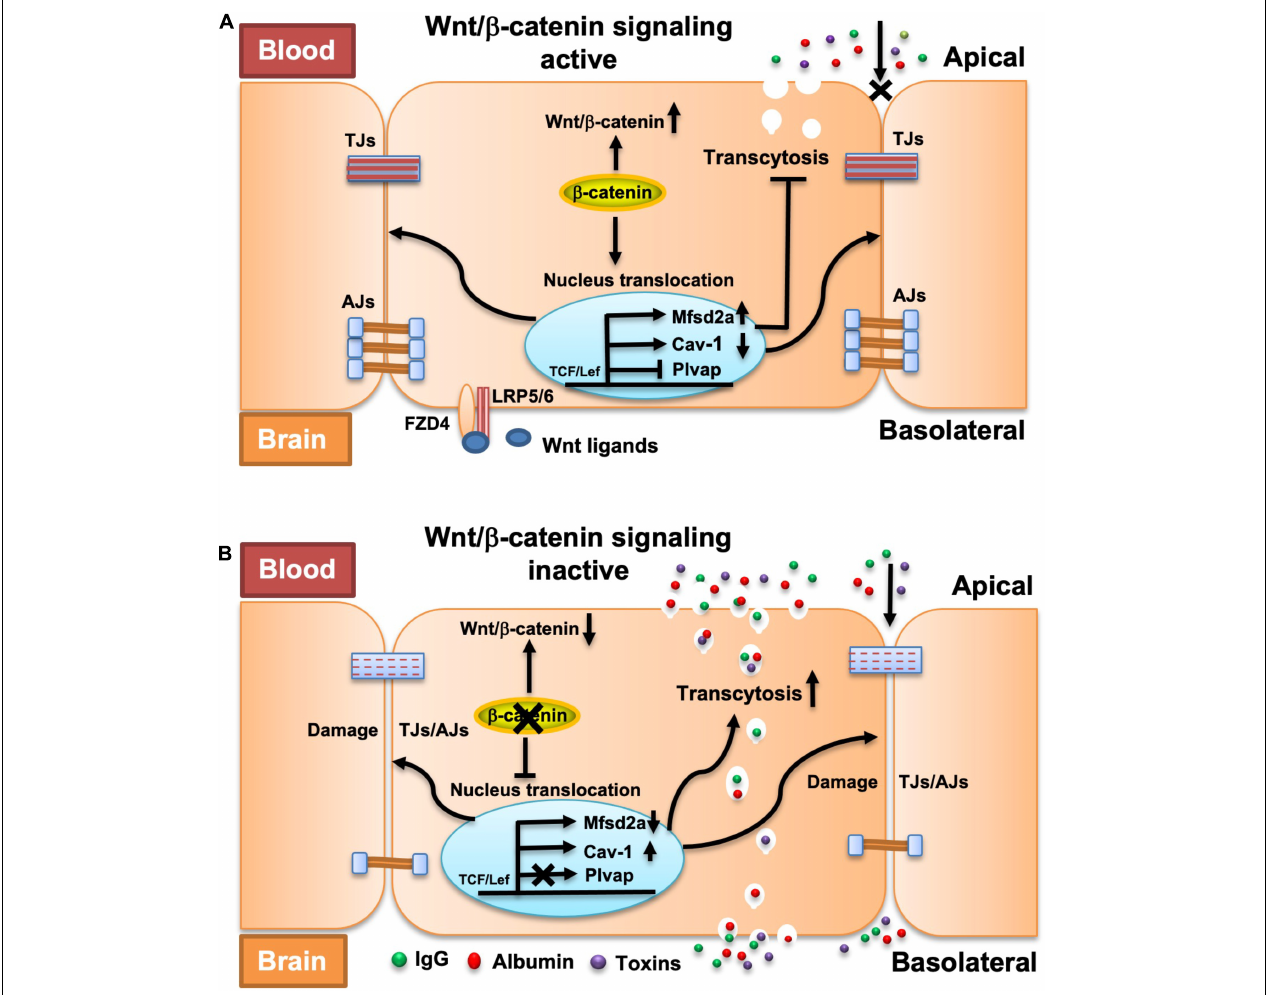
FIGURE 7 | Proposed model explaining the impact of endothelial β -catenin deficiency on intercellular junctions, transcytosis, and fenestrations in BBB ECs. (A) In a healthy state or the presence of β -catenin, a natural Wnt ligand (Wnt3a) or GSK-3 β inhibitor (LiCl) that activates the Wnt/ β -catenin signaling pathway, TJs and AJs are strengthened, and endothelial transcytosis and expression of Plvap is repressed, thereby collectively maintaining the BBB integrity. (B) In the disease state, or with the deletion of β -catenin that compromises the Wnt/ β -catenin signaling pathway, TJs and AJs are weakened and endothelial transcytosis is increased, which lead to BBB breakdown. No fenestrations and expression of Plvap are induced upon acute deletion of endothelial β